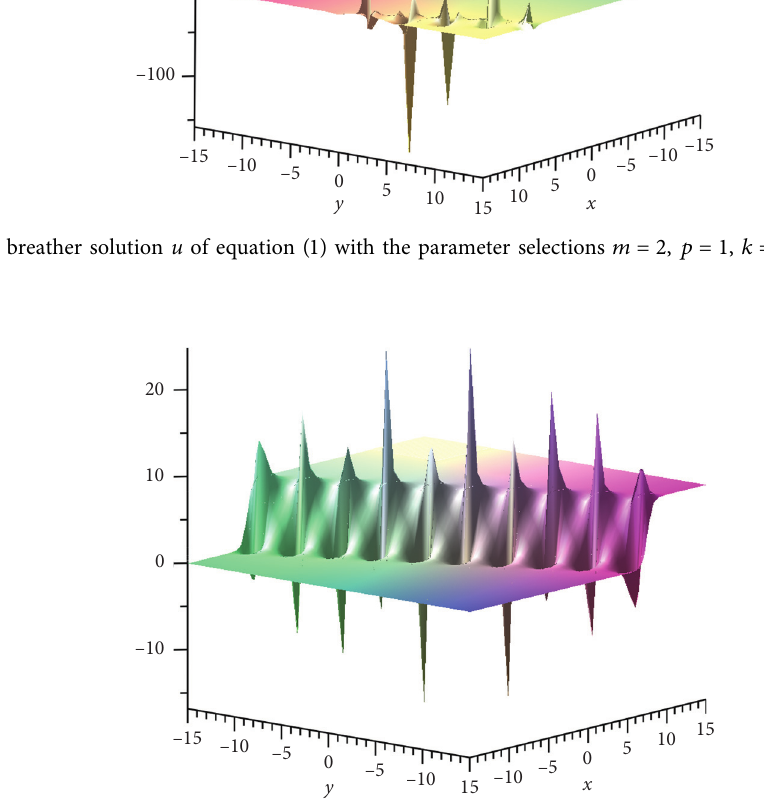
Figure 6: The breather solution v of equation (1) with the parameter selections m � 2 , p � 1 , k � 2 , δ